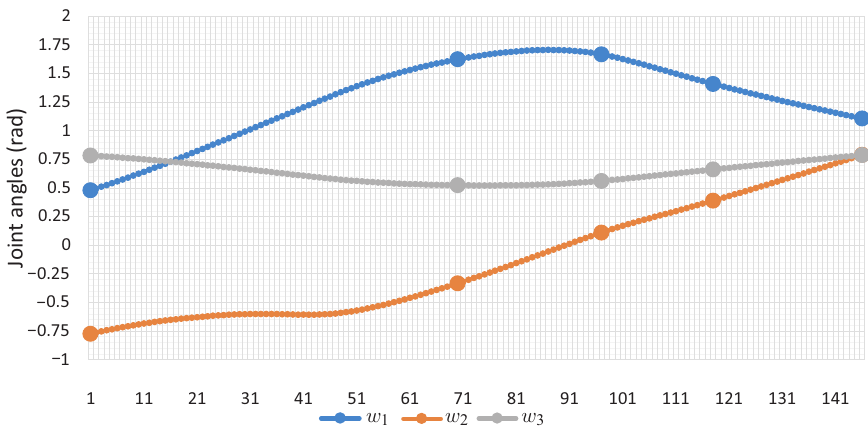
Figure 11. Joint angles motion of Case Study